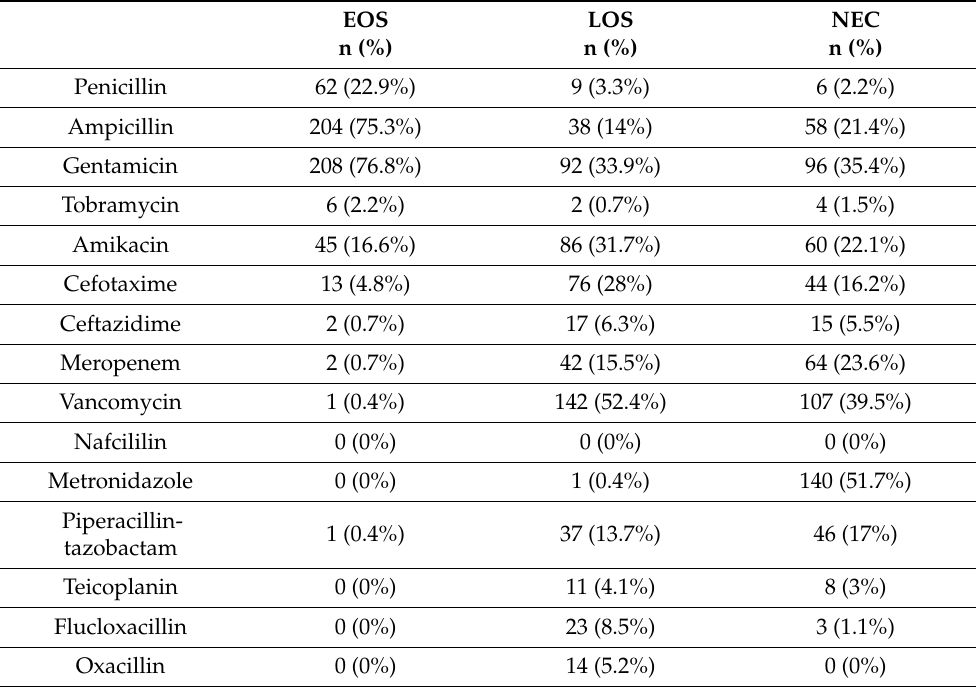
Table 2. Summary of which antibiotics were used by the consulted NICUs in early-onset sepsis, late-onset sepsis, or necrotizing enterocolitis, respectively. EOS n (%)